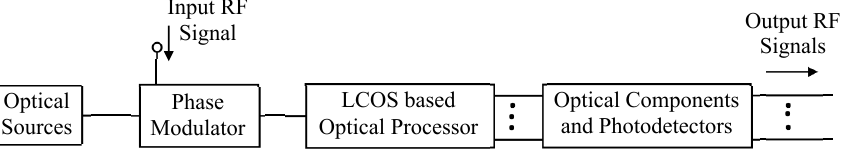
Figure 2. The structure of a microwave photonic device based on LCOS technology.